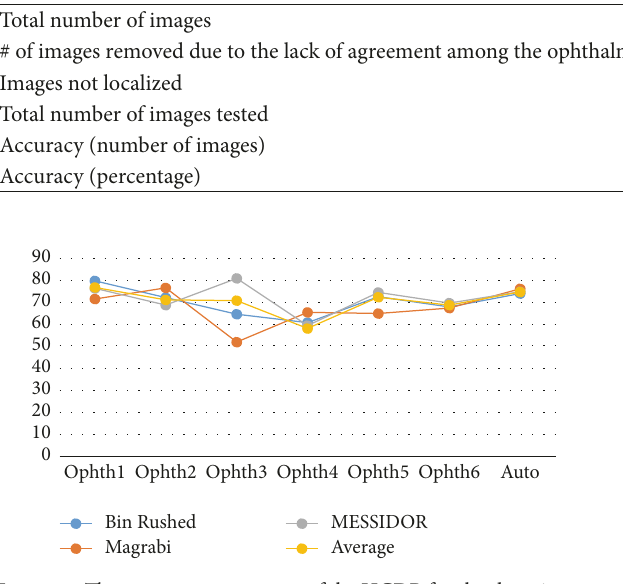
Figure 5: The percentage accuracy of the HCDR for the three image sets separately and together.